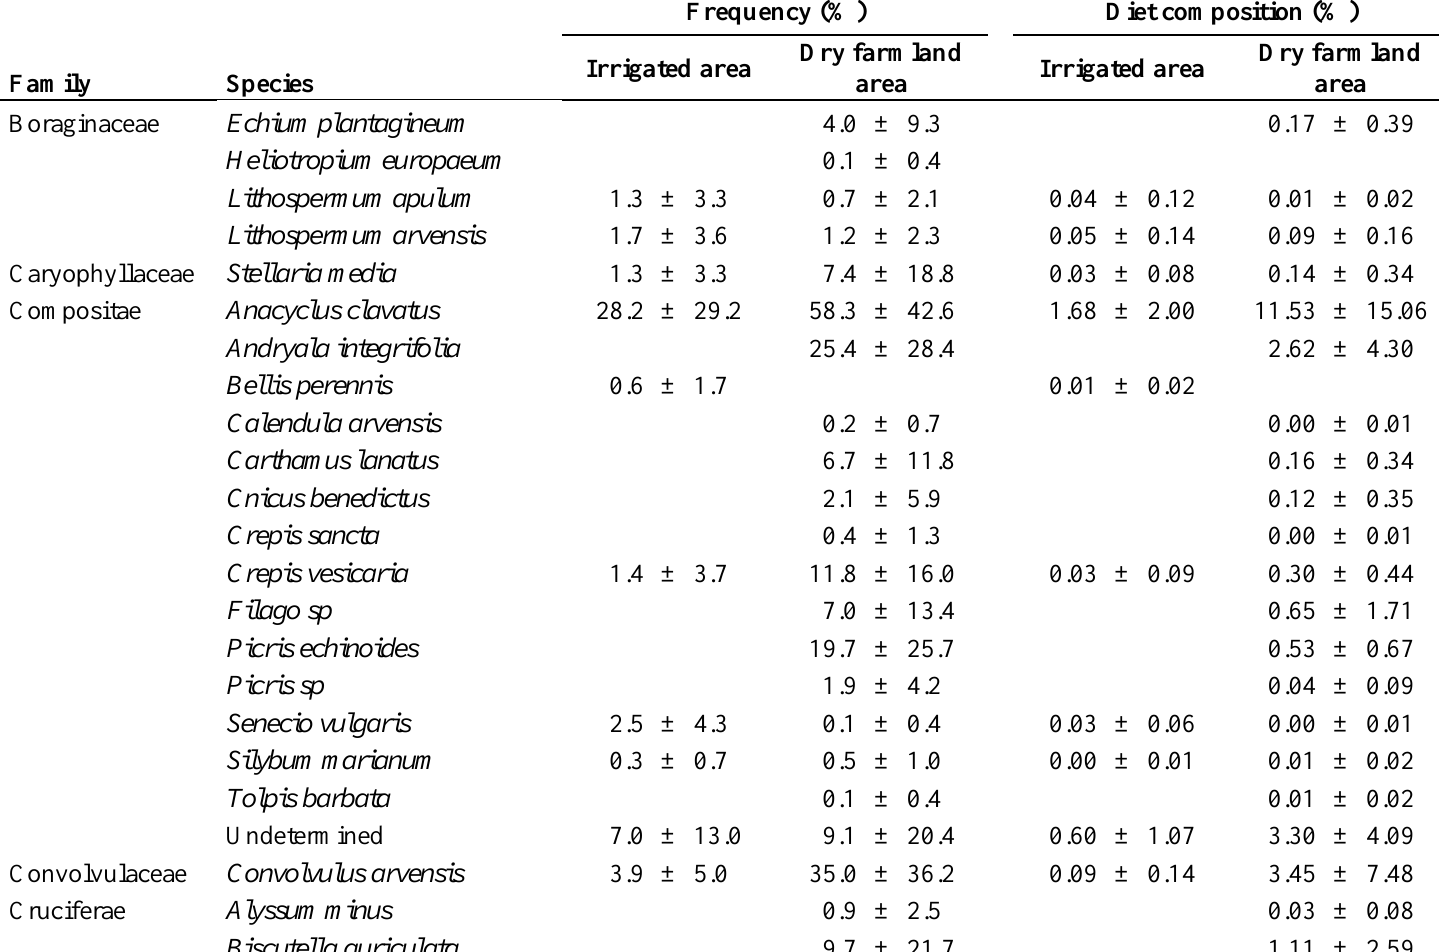
Table A1.2. Plant species identified in Little Bustard diet sorted by irrigated (n=8) and dry (n=8) farmland areas. Frequency of each plant species is expressed as the average percentage (±SD) of droppings in which the species appears, and diet composition is shown as the average (±SD) percentage of microscope fields with presence of each species per dropping. Averages were based on the mean of the 8 sampling sites per